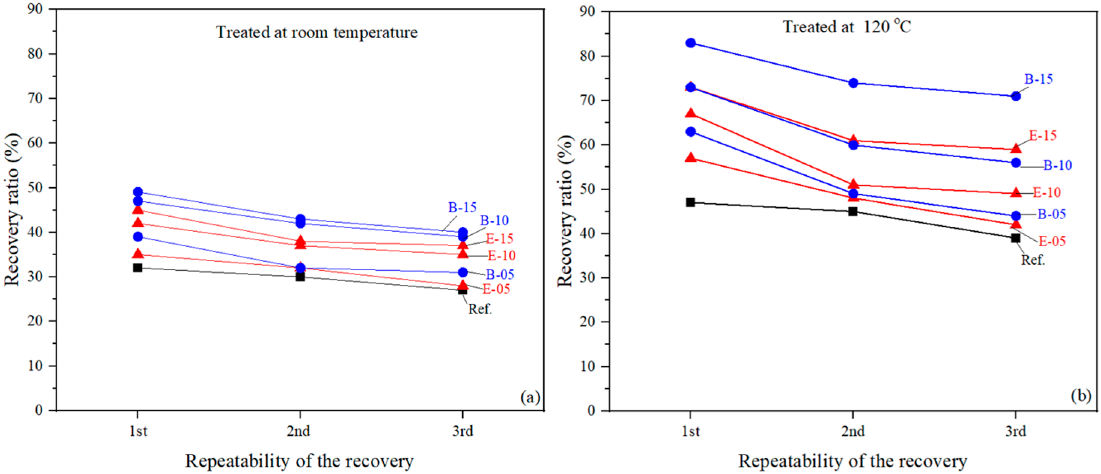
Figure 11. The recovery ratio of silica - filled NR vulcanizates with different EMZ loading levels treated at ( a ) room temperature and ( b ) 120 °C for three rounds of the cyclic test .